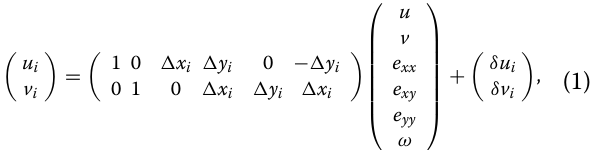
Model parameters to be estimated are velocity v and its spatial derivatives ∂ x v and ∂ y v at a position P key point in the estimation is that the fitting errors δ v i are weighted according to the distance between the observa- tion point ( x i , y i ) and the estimation point P as